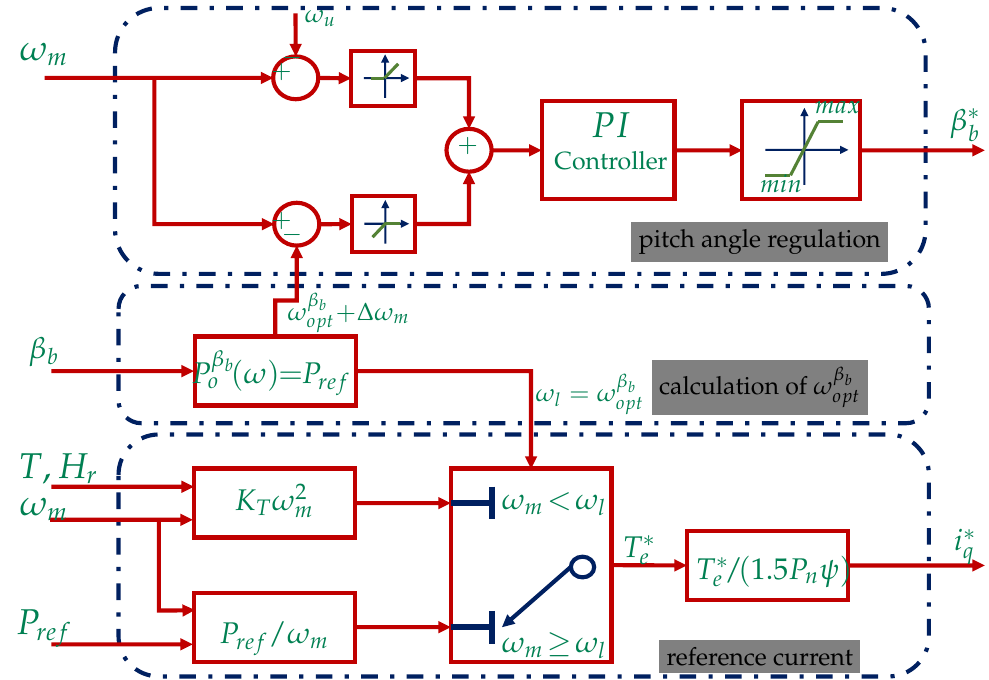
Figure 19. Active power control for reference power tracking with pitch angle